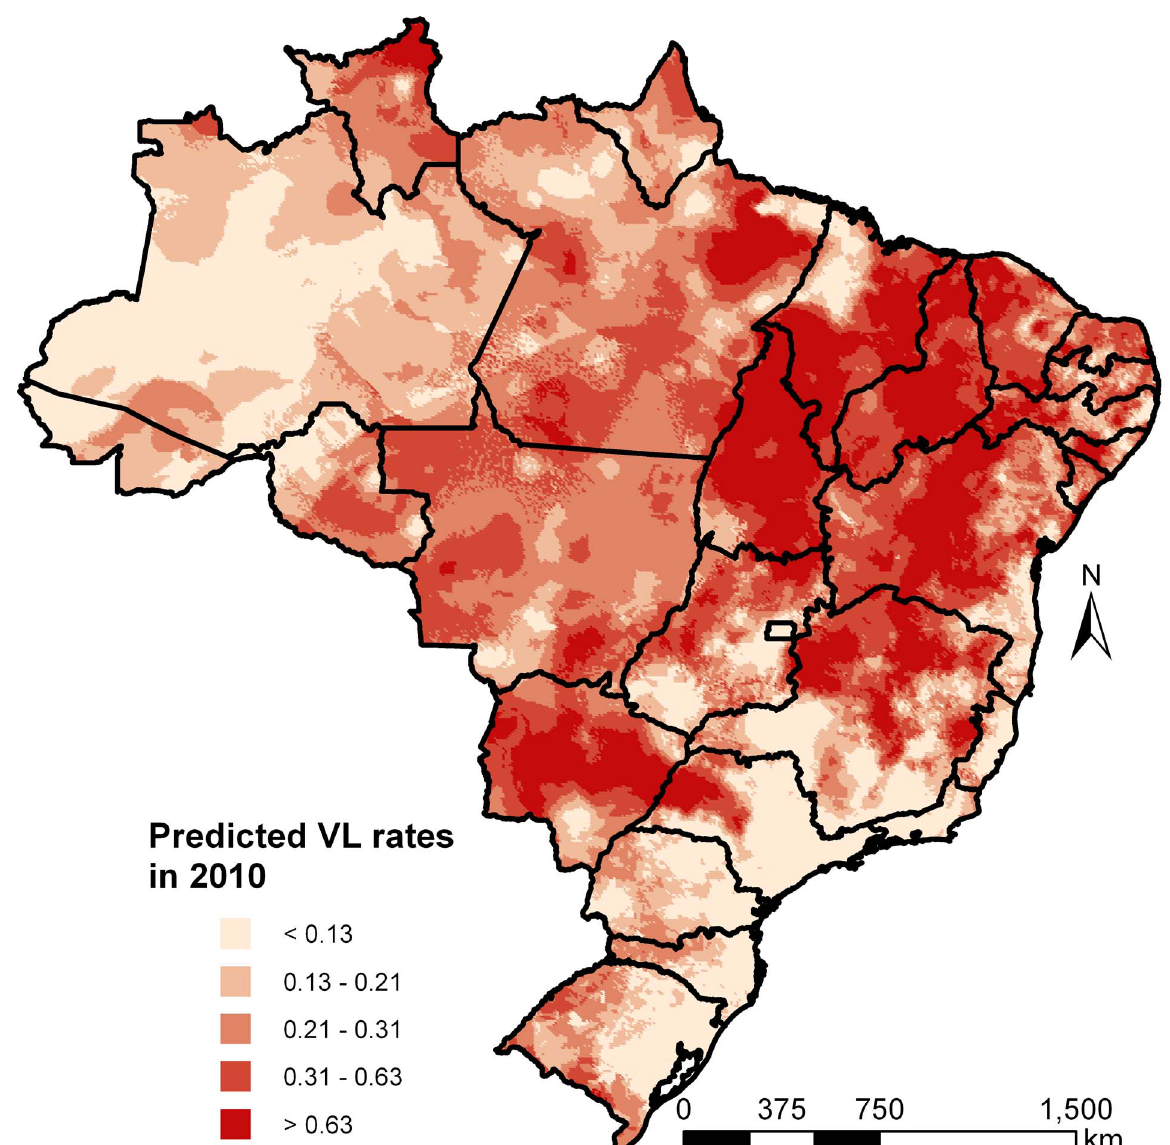
Figure 4. Geostatistical model-based predicted incidence rates per 10,000 for visceral leishmaniasis in Brazil in 2010.